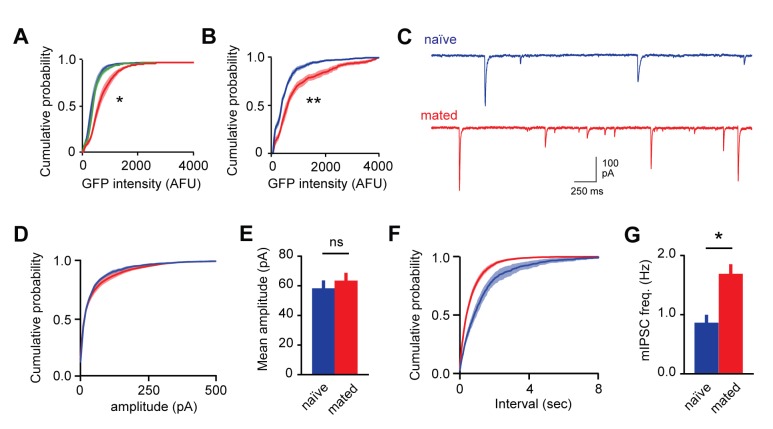
Mating increases fluorescent labeling in AOB and increases inhibitory synaptic input onto MCs.(A) Cumulative histogram of Arc-GFP intensity. Mating, but not sensory exposure alone, increases labeling in GCs (p<10−45, Kolmogorov–Smirnov test; n = 14, 9, and 18 slices for naïve, sensory-exposed, and mated groups respectively). (B) Mating produces robust increases in Fos-GFP labeling of MCs (p=0.0004, Kolmogorov–Smirnov test; n = 8 and 7 slices from 4 and 5 mice for naïve and mated groups respectively). (C) Representative synaptic currents measured from naïve and mated females. Currents are inward due to a high chloride recording solution. (D) Cumulative distribution of event amplitude (p<0.001; Kolmogorov–Smirnov test; n = 6 and 16 cells in 3 and 5 mice). (E) The mean amplitude of inhibitory currents is unchanged in MCs from naïve and mated (red) animals (p=0.29; t-test). (F,G) Mating increased the frequency of inhibitory input to MCs, reflected in both the leftward shift in the distribution of event intervals and increase in mean frequency (p=0.001; t-test).